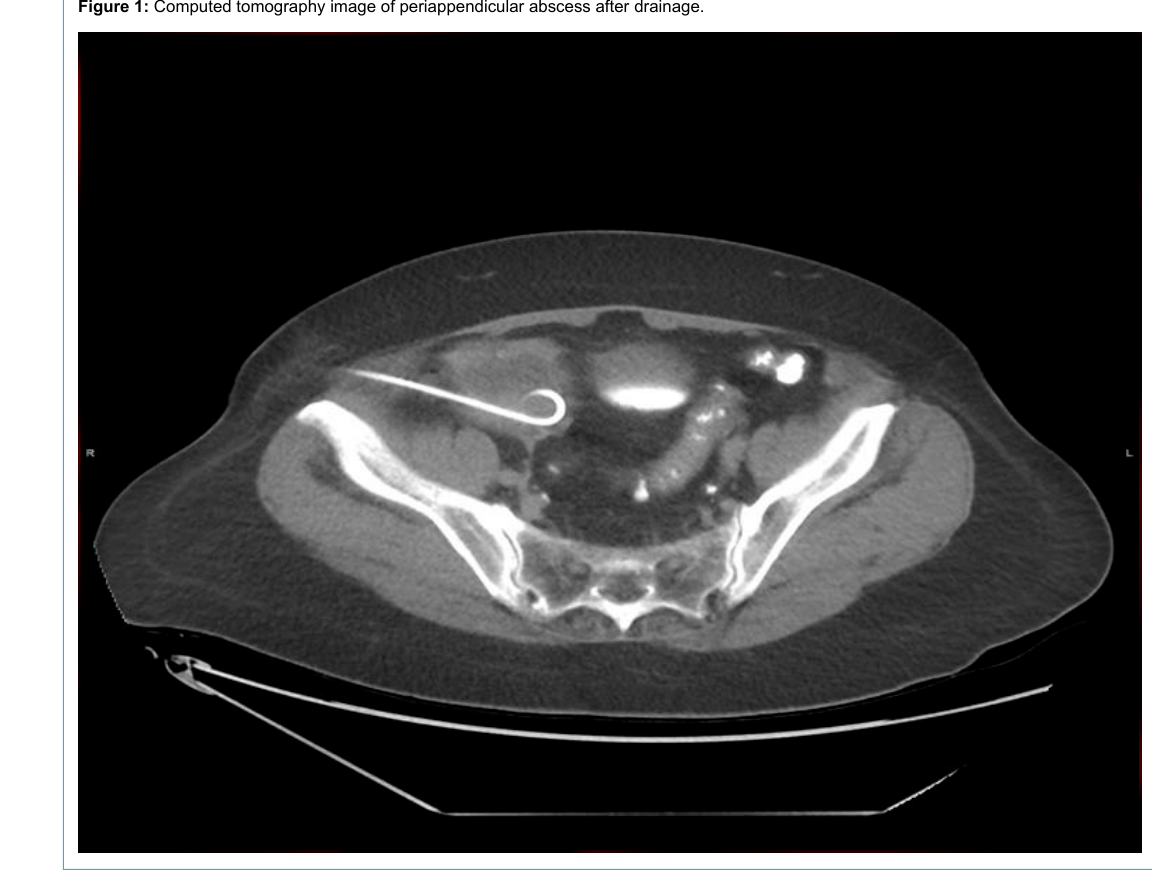
Figure 1: Computed tomography image of periappendicular abscess after